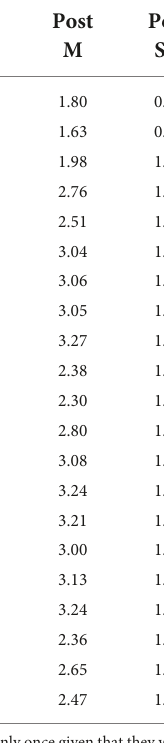
TABLE 2 Emotions at pre- and post-test as a function of text